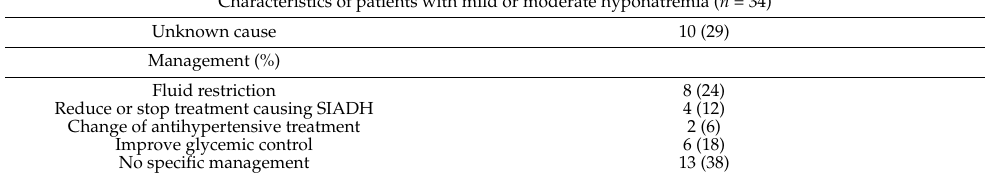
Table 2. Cont. Characteristics of patients with mild or moderate hyponatremia ( n =